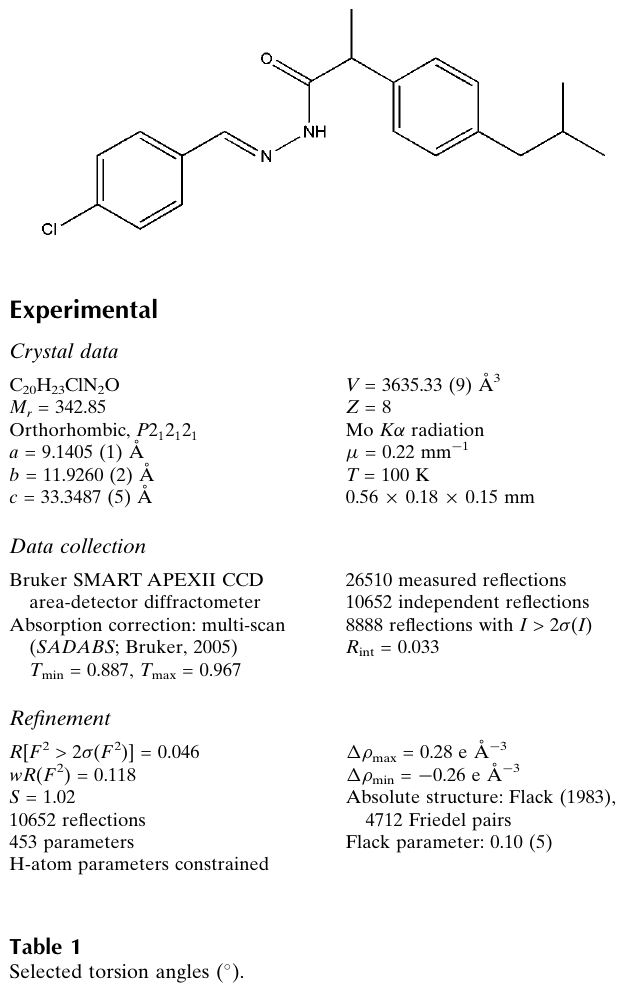
Bruker SMART APEXII CCD area-detector diffractometer